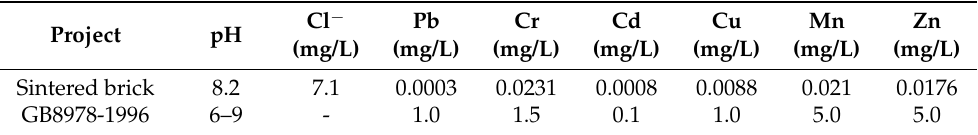
Table 7. pH value of pollutants, mass concentration of Cl − and heavy metals in sintered brick leaching solution.